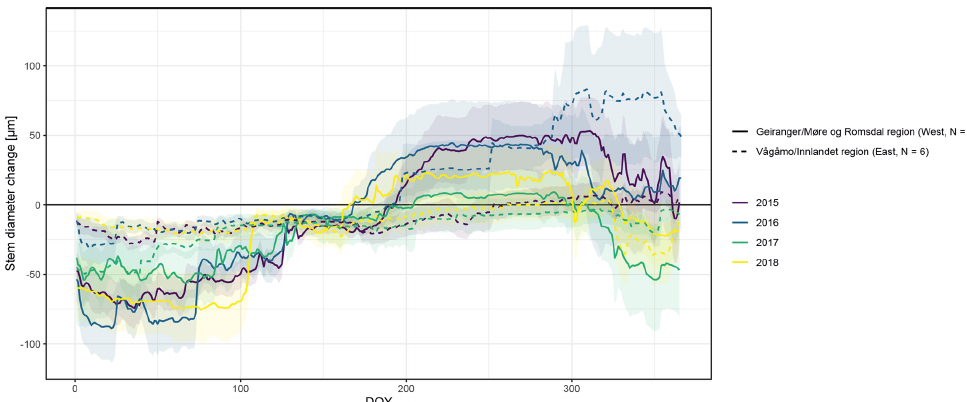
Figure A4. Observed stem diameter change averaged over the monitored specimens within each of the two study regions (Vågåmo, Innlandet, region (east, N = 6) and Geiranger, Møre og Romsdal, region (west, N = 6)). Transparency indicates standard deviation.